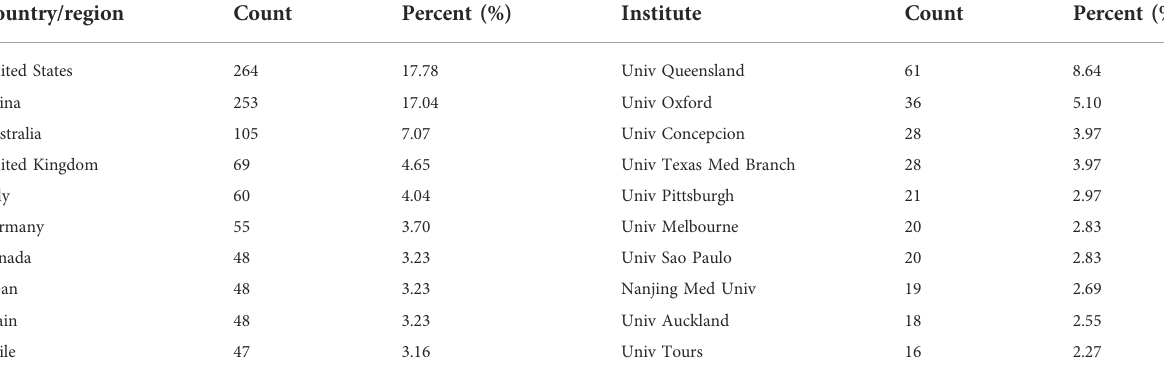
TABLE 1 Distribution of publications on exosomes in reproduction across different countries and institutions. Country/region